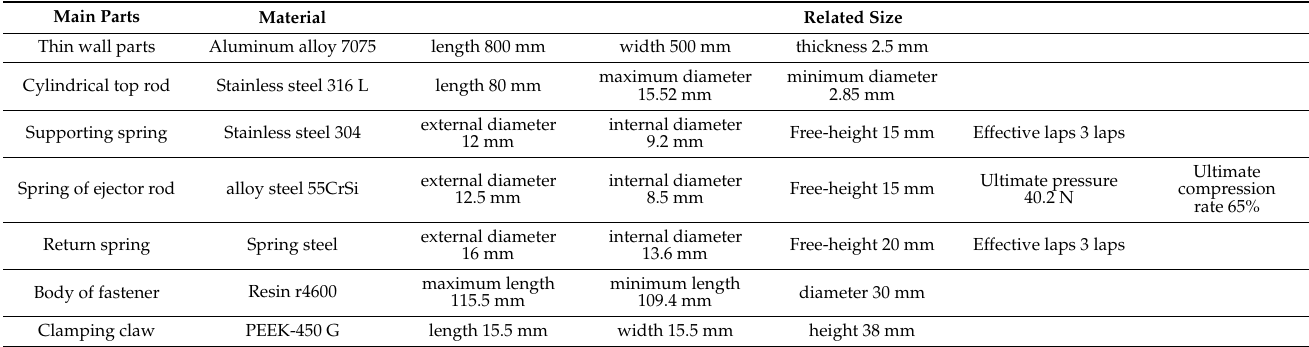
Table 2. Main parameters of parts.